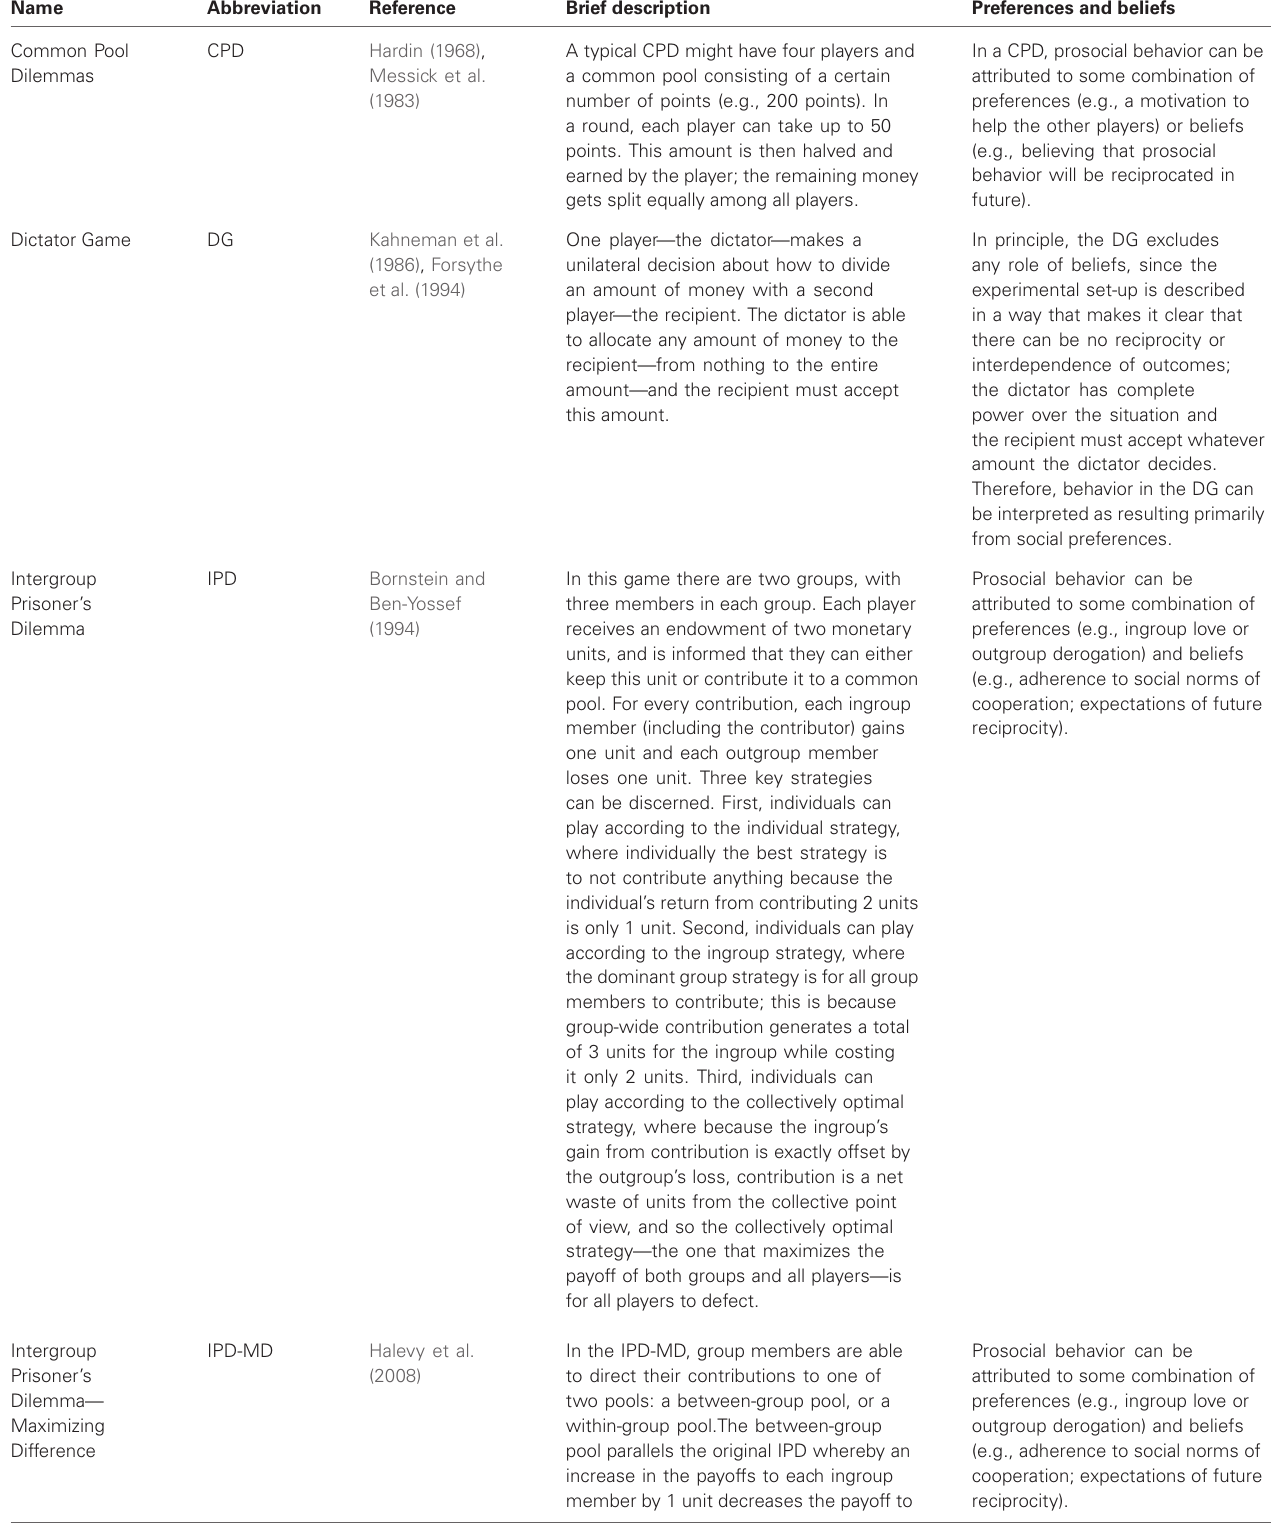
Table 1 | Commonly used behavioral economic games to study intergroup prosocial behavior